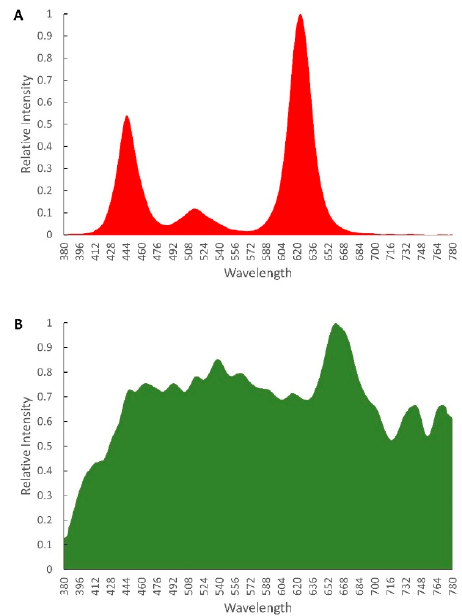
Figure 2. Spectral distribution of light treatments used for photoperiod experiments. ( A ) Artificial light treatment. All treatments used equal spectral distribution but with varying intensities and photoperiod. ( B ) Spectral distribution of natural daylight measured at the greenhouse.